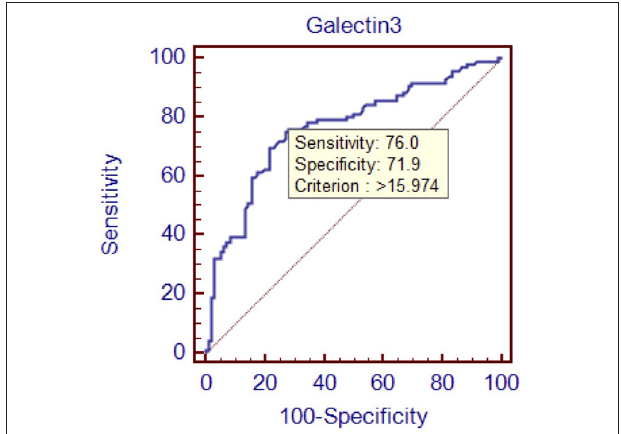
FIGURE 1 | Receiver operating characteristic curve of galectin-3 to diagnose HFPEF. Area under the curve: 0.763, 95% C.I. (0.696–0.821), P <